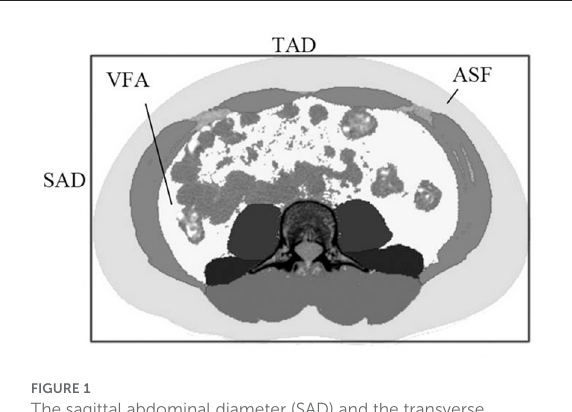
FIGURE1 The sagittal abdominal diameter (SAD) and the transverse abdominal diameter (TAD) in the abdominal cross-sectional image, with subcutaneous adipose tissue and visceral adipose tissue represented in light gray and white, respectively.